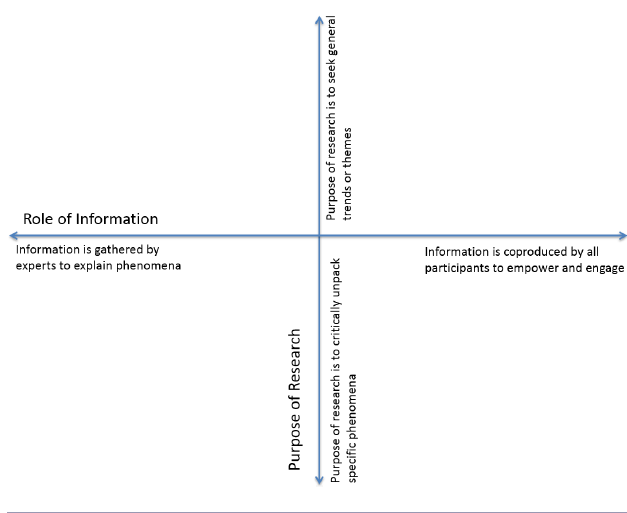
Fig. 1 . The research